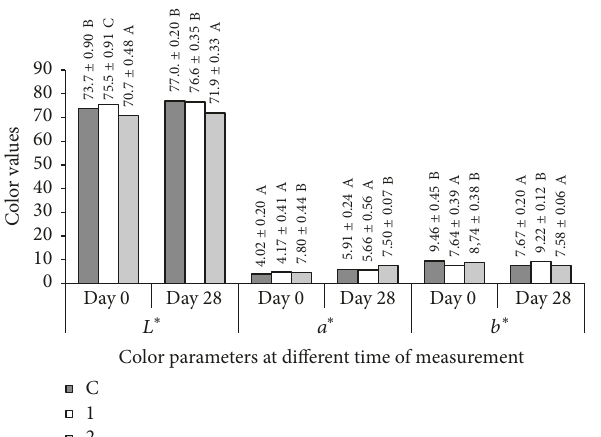
Figure 2: CIE 𝐿 ∗ , 𝑎 ∗ , and 𝑏 ∗ indicate values of meat products; ABC different letters indicate significant differences ( 𝑃 ≤ 0.05 ) between values.